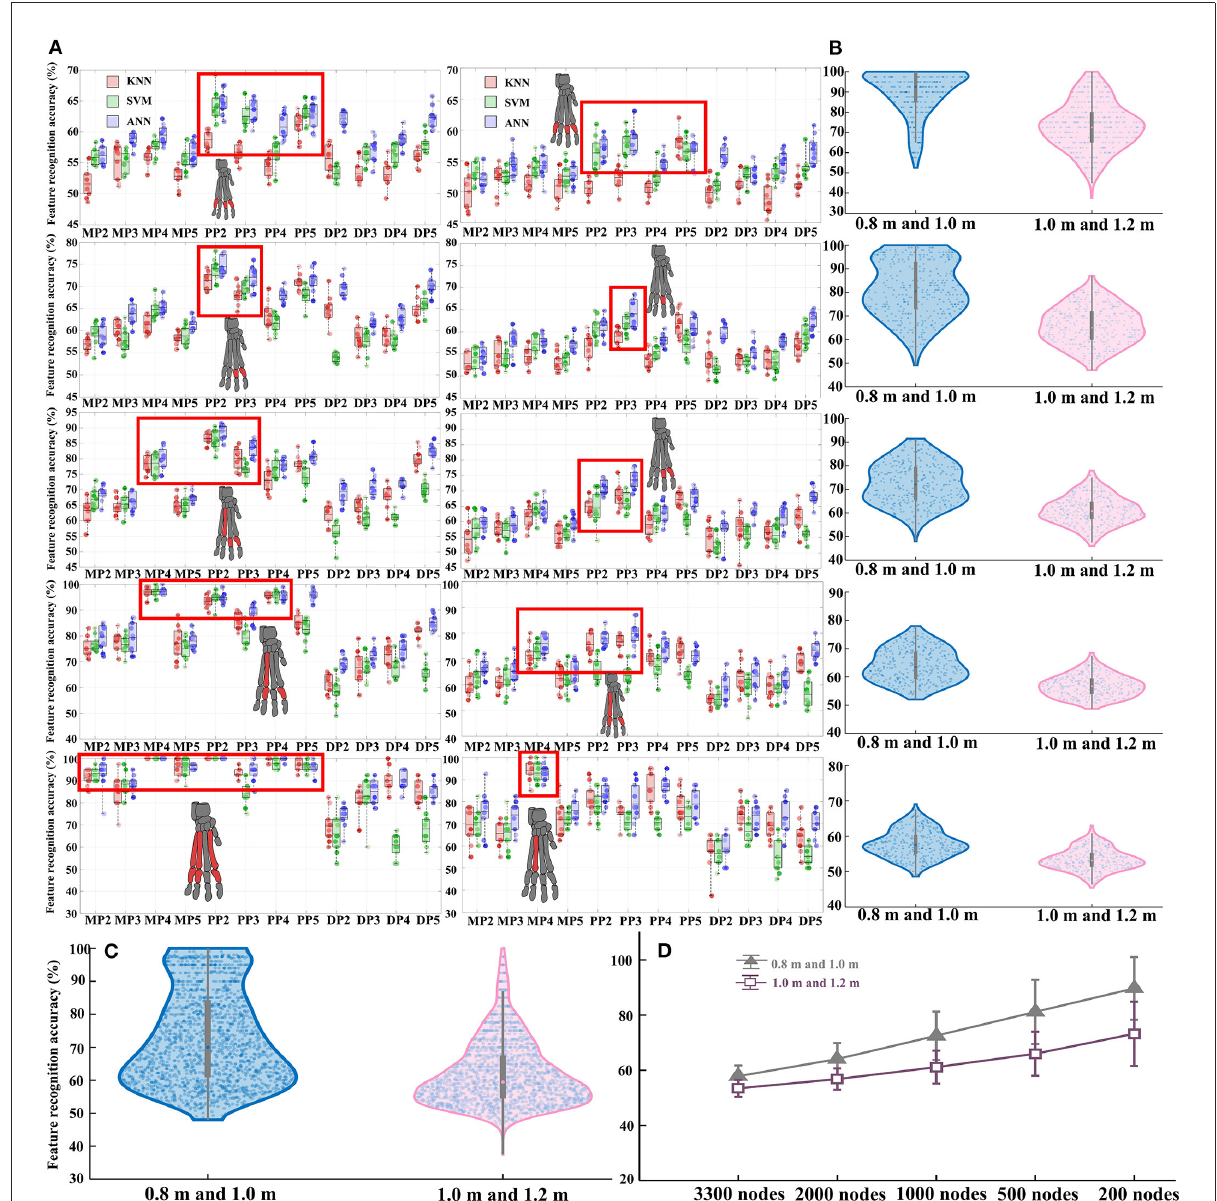
FIGURE6 (A) Detailed results of features classification and recognition accuracy rate in each contrasting situation of the three different classification algorithm models. The left side is the feature classification and recognition results based on the data of landing from 0.8 to 1.0m, and the right side is the feature classification and recognition results based on the data of landing from 1.0 to 1.2m. From top to bottom are the results based on the stress value data corresponding to all nodes, the data of the first 2,000 nodes with the highest stress values, the data of the first 1,000 nodes with the highest stress values, the data of the first 500 nodes with the highest stress values, and the data of the first 200 nodes with the highest stress values, respectively. In the red box are the features with higher classification and recognition accuracy than other features, corresponding to the claw bones marked in red. (B) Total classification and recognition accuracy data distribution of all features in each node control case. (C) Total classification and recognition accuracy of all features under two contrasting situations. (D) The final classification recognition accuracy trend of all features in each node control